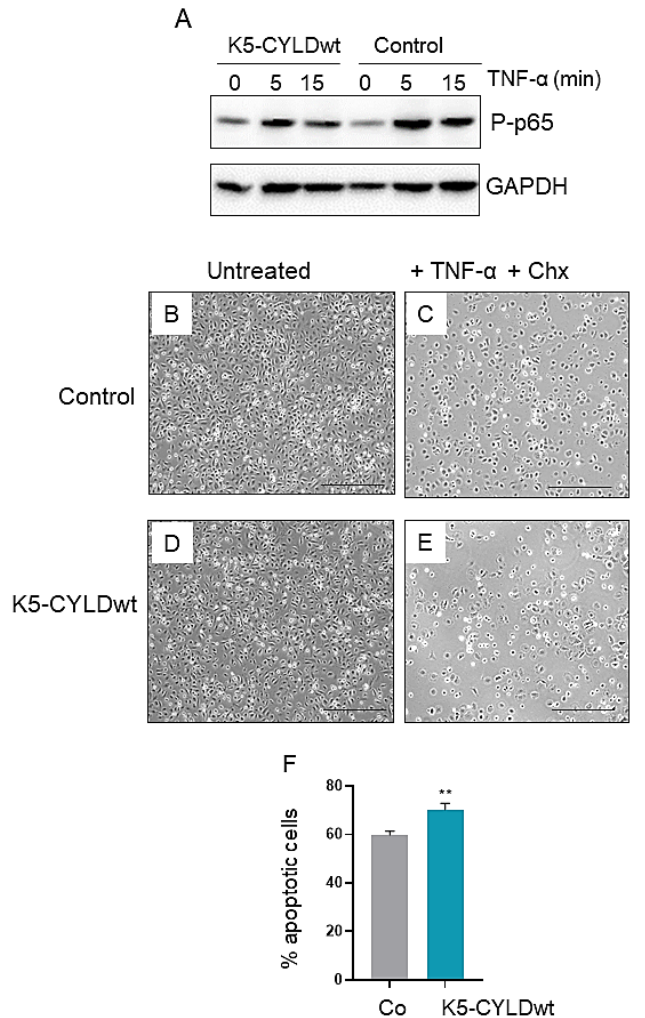
Figure 3. Reduced NF- κB activation of CYLDwt keratinocytes and decreased survival of transgenic keratinocytes upon exposure to an apoptotic stimulus. ( A ) Kinetics of p65 phosphorylation in the back skin of 3-day-old Control and transgenic mice inoculated with TNF- α for the indicated times. Control ( B , C ) and transgenic ( D , E ) keratinocytes were grown in the absence ( B , D ) or presence ( C , E ) of TNF- α and cycloheximide (Chx) for 15 h. Representative images showing increased number of viable cells in Control plates are shown. Scale bars ( B , E ): 1000 µm. ( F ) Graphical representation showing the significantly higher percentage of transgenic keratinocytes dying by apoptosis. Data are shown as mean ± SEM; ** p < 0.01 by two-tailed t -test with Welch’s correction.